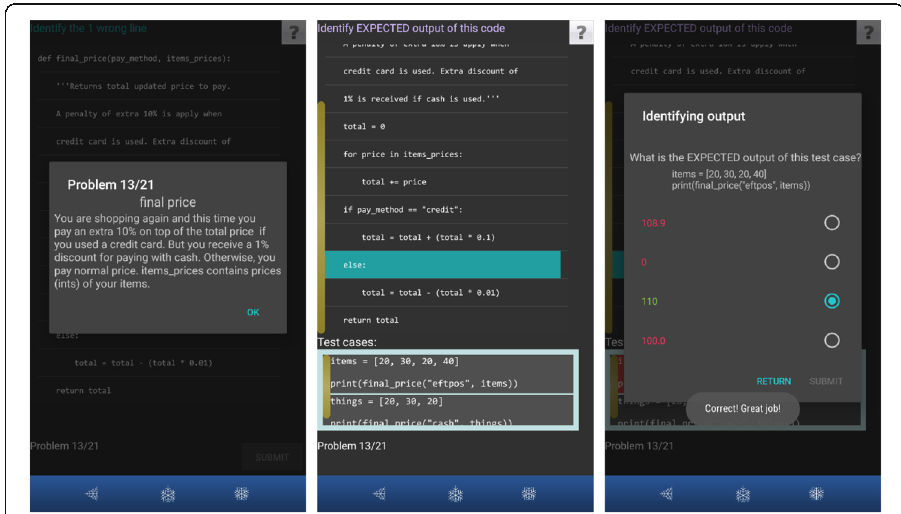
Fig. 3 Example of an Out_Exp activity in PyKinetic_DbgOut (left: problem description; middle: code with erroneous LOC already identified, right: output prediction question for the first